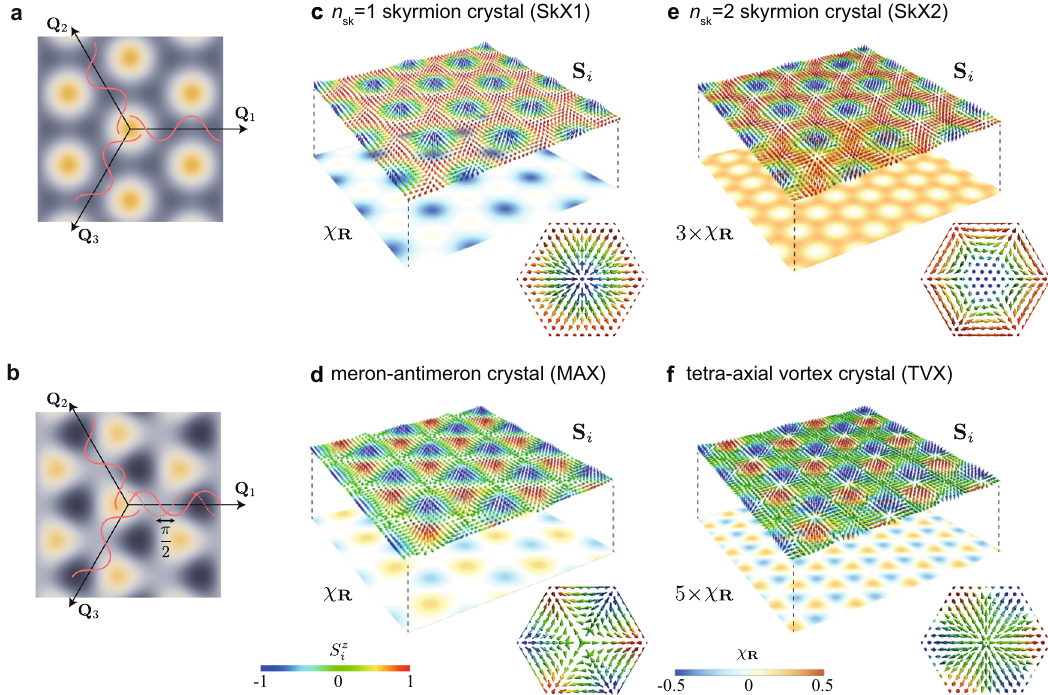
Fig. 1 Phase shift and interference patterns. a , b Superpositions of three density waves with the wave vectors Q 1 , Q 2 , and Q 3 . b is the fi gure generated from a with the phase shift of π /2 in Q 1 , which breaks sixfold rotational symmetry in a . c , d superpositions of three spirals waves: the n sk = 1 skyrmion crystal (SkX1) ( c ) and the meron-antimeron crystal (MAX) ( d ). e , f Superpositions of three sinusoidal waves: the n sk = 2 skyrmion crystal (SkX2) ( e ) and the tetra-axial vortex crystal (TVX) ( f ). d , f are generated from ( c ) and ( e ), respectively, with the phase shift of Θ = π /2, and both of them break sixfold rotational symmetry similar to b . In c – f , the upper and lower planes show the spin S i ¼ ð S x i ; S y i ; S z i Þ [the color scale indicates S z i , and the arrows indicate ð S x i ; S y i Þ ] and the scalar chirality χ R , respectively. The spin textures in the magnetic unit cell are shown in the insets of c – f